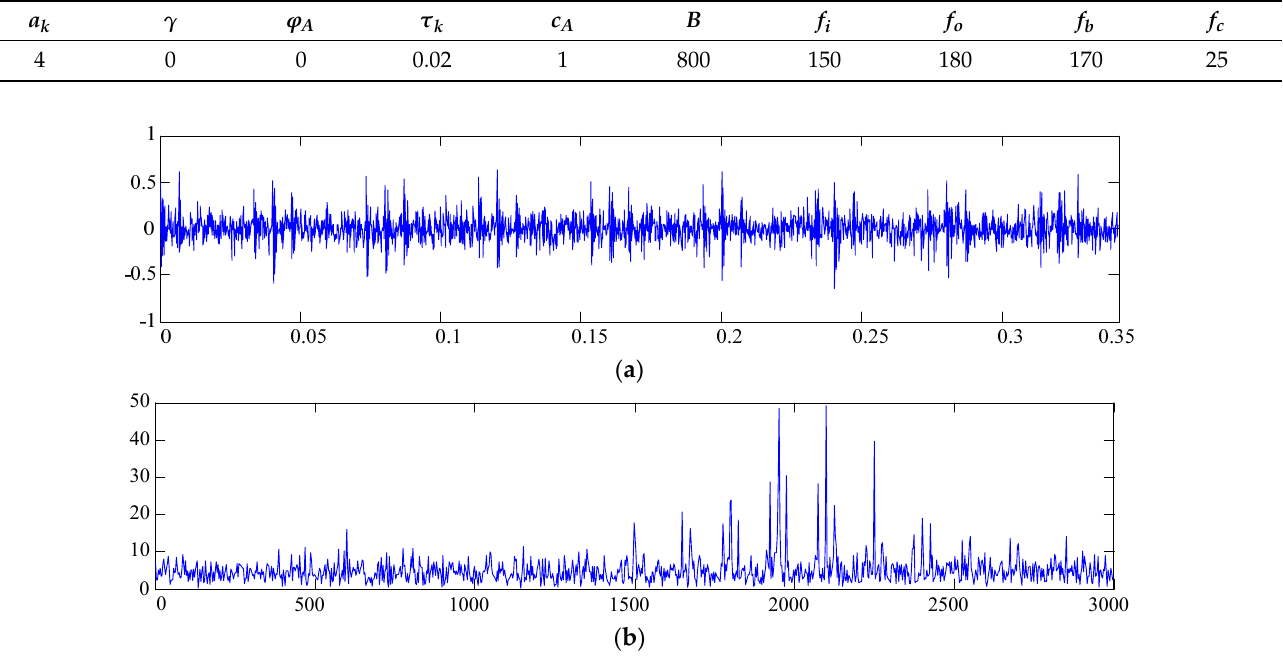
Figure 5. Time and frequency domain of simulation signal. ( a ) Time domain; ( b ) frequency domain.